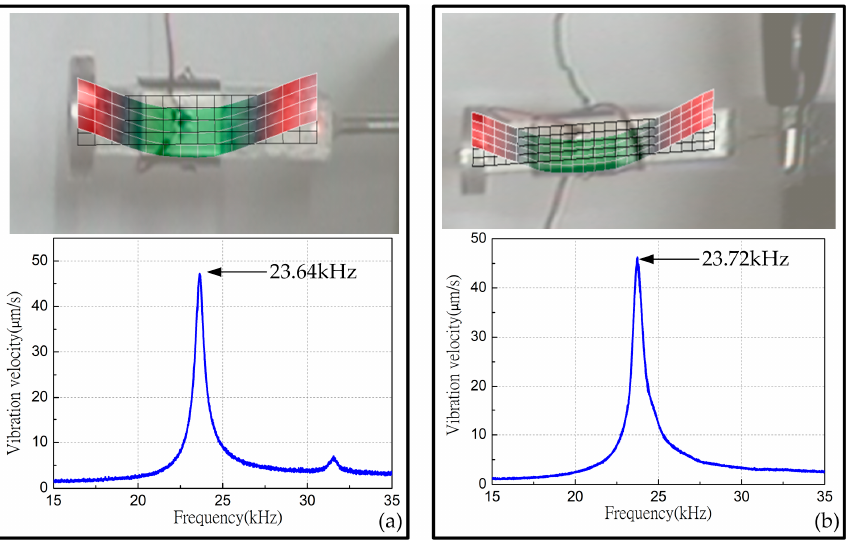
Figure 6. The vibration test results of one leg: ( a ) Real vibration shape and the corresponding frequency in horizontal direction; ( b ) Real vibration shape and the corresponding frequency in vertical direction.